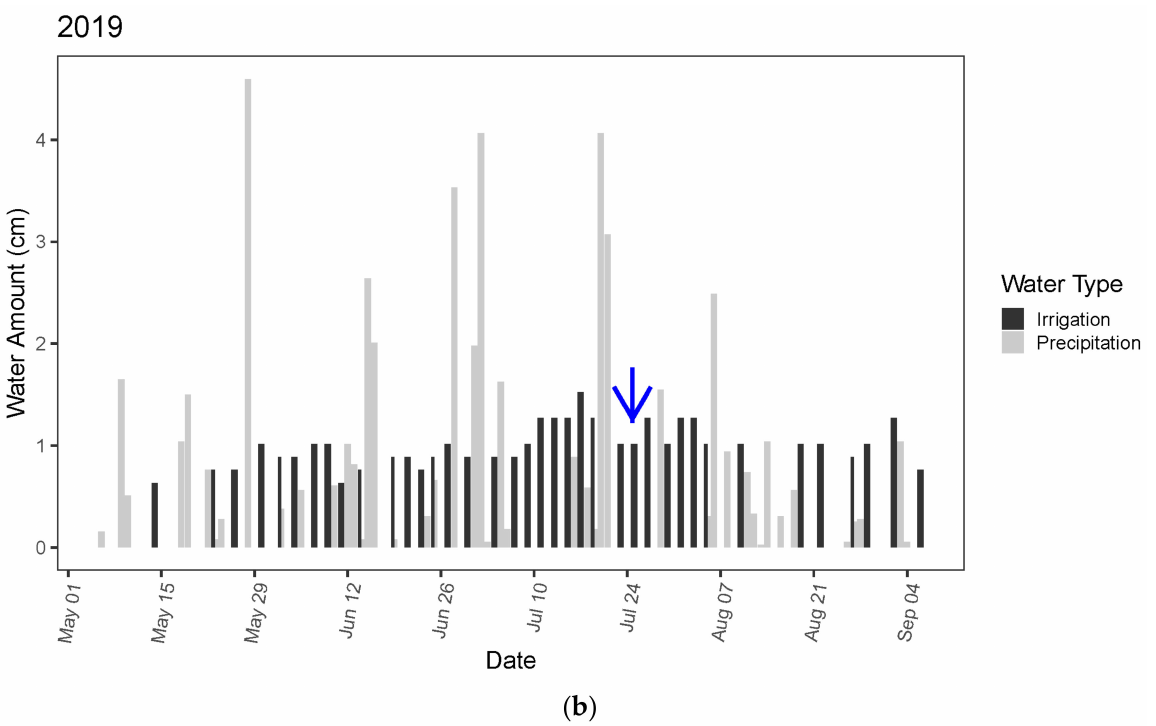
Figure 2. Irrigation (black bars) and precipitation (grey bars) records at the University of Wisconsin (UW) Hancock Agricultural Research Station in 2018 ( a ) and 2019 ( b ). The blue arrow in each graph indicates date of irrigation treatment initiation (25